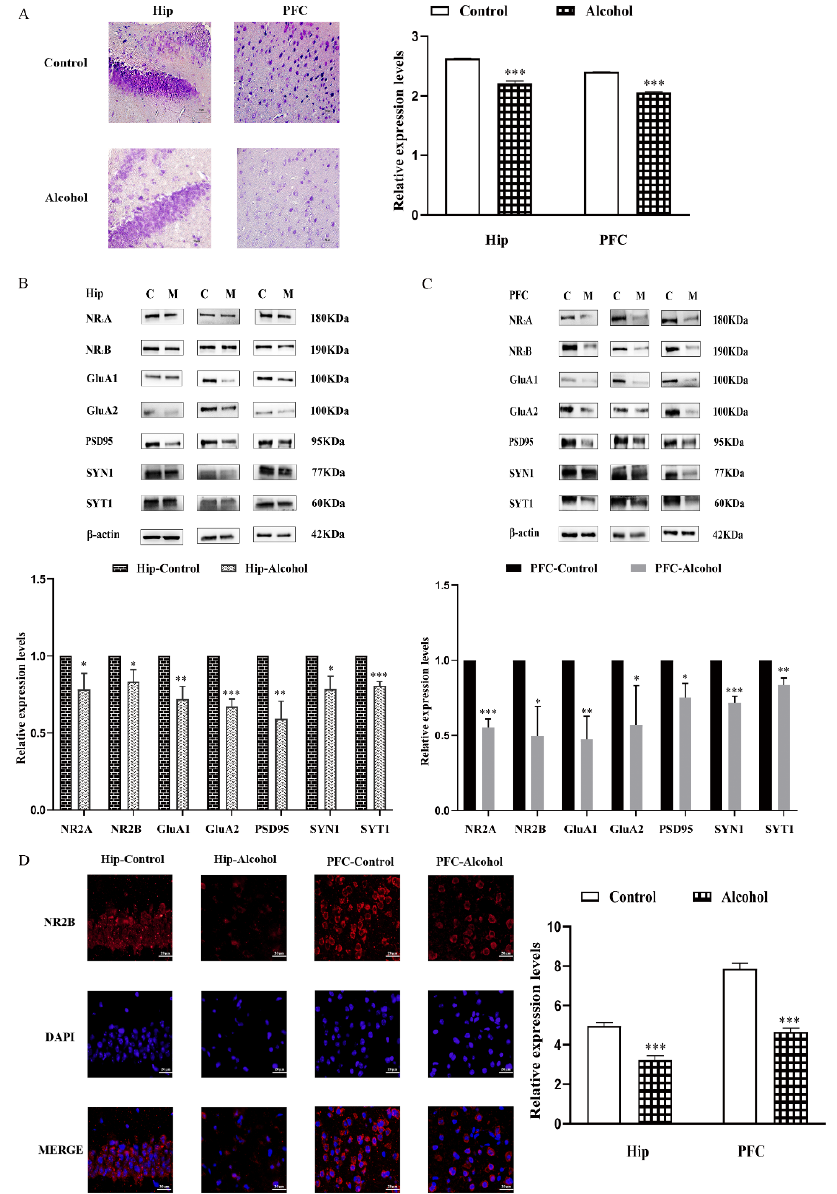
Figure 3. Alcohol exposure downregulated the expression of synapse-related proteins in the hippo- campus (Hip) and prefrontal cortex (PFC). ( A ) Nissl staining of Hip and PFC (magnification: 400×), ( B ) Western blot analyses for synapse-related proteins in Hip, ( C ) western blot analyses for synapse-related proteins in PFC, and ( D ) immunohistochemistry (IHC) showing N -methyl- D -aspartic acid receptor 2B (NR2B) (red) staining in the Hip and PFC (magnification: 400 × ), nuclei are stained with diamidino-2-phenylindole (DAPI) (blue). Data are presented as the mean ± SEM. Statistical analysis was carried out by Student’s t test, * p < 0.05, ** p < 0.01, *** p < 0.001 vs. control group.